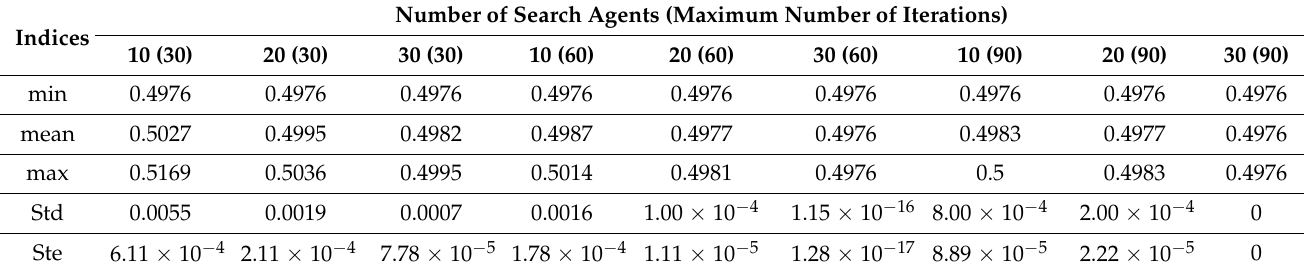
Table 5. Sensitivity analysis of different setting scenarios for the proposed